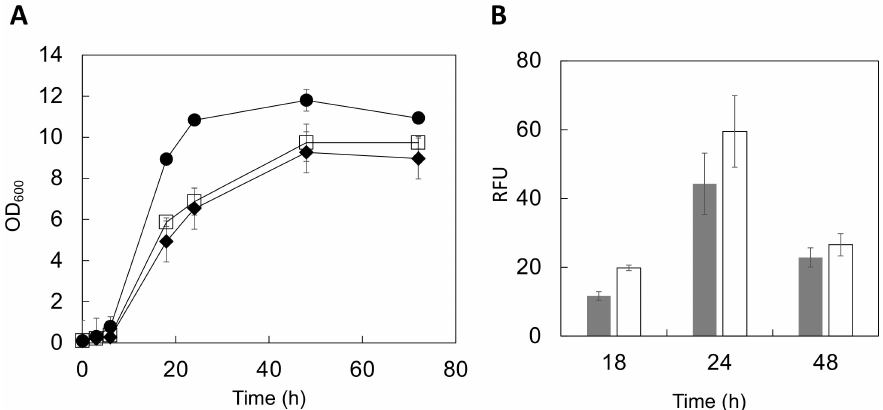
Figure 3. Evaluation of HGF-displaying cells during culture. ( A ) Cell growth. Circle, control; square, BY4741/HGF-FL (full length), diamond, BY4741/HGF-HC (heavy chain). ( B ) The fluorescence intensity from the yeast cell surface was measured and expressed in relative fluorescence units (RFU). Gray, BY4741/HGF-FL; White, BY4741/HGF-HC. Data represent the means ± SD of three independent experiments. SD, standard deviation; HGF, hepatocyte growth